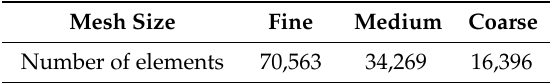
Table 2. The number of elements in di ff erent groups to check the resolution independence of the numerical grid.